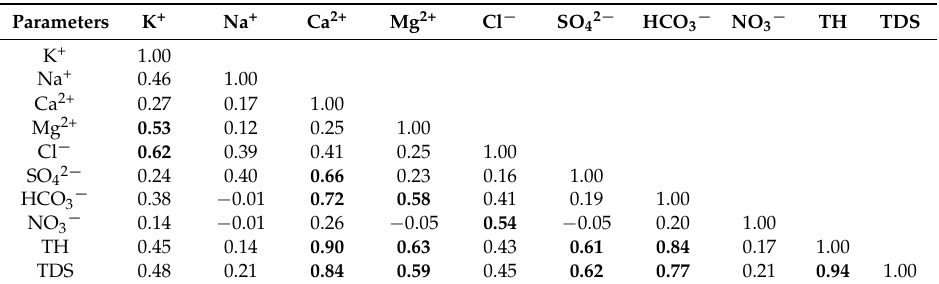
Table 2. Pearson correlation matrix of groundwater samples in the study